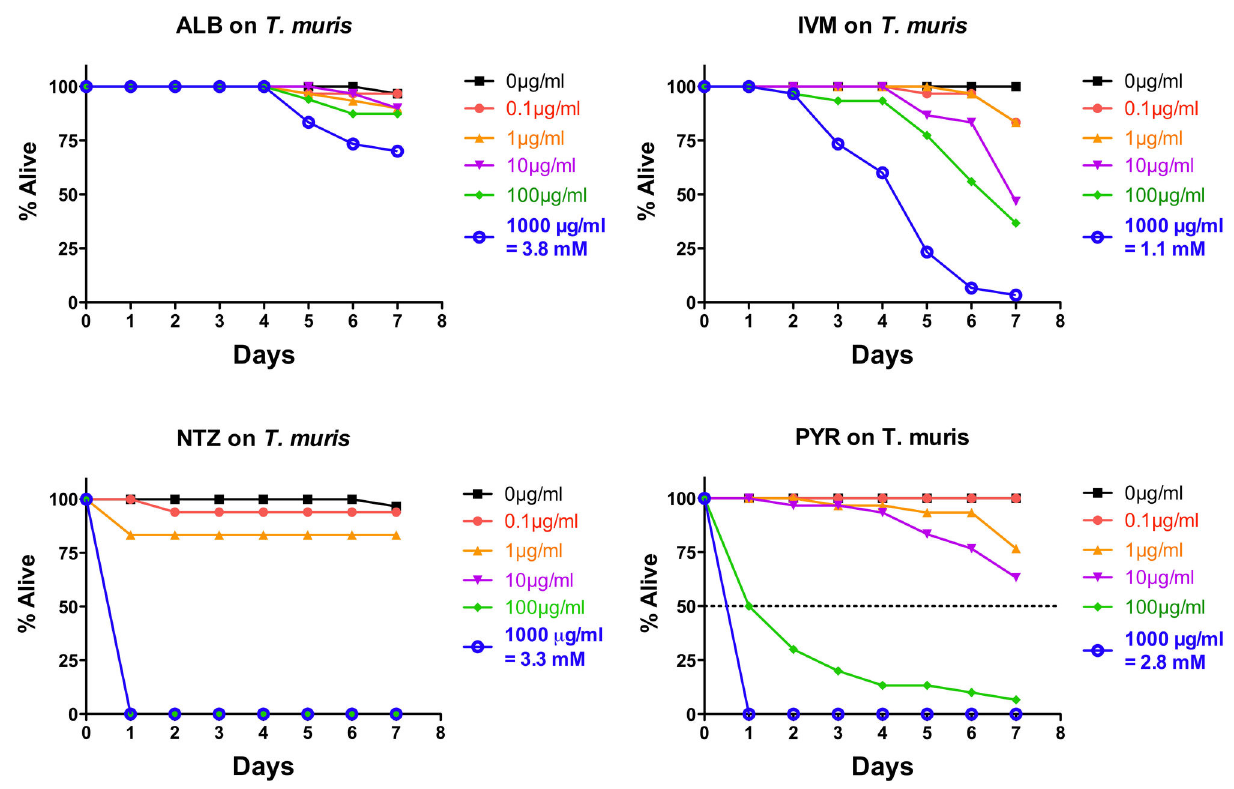
Figure 3. Intoxication of Trichuris muris adults in vitro using five doses of albendazole (ALB), ivermectin (IVM), nitazoxanide (NTZ), or pyrantel (PYR). For comparative reference, the molar concentration of each drug at 1000 µg/mL is indicated. Parasites were scored daily for motility. Any motility, including motility after prodding, was counted as “alive.” Lack of motility, including lack of a response after prodding, was counted as “dead.” Data are the combination of three independent trials with 10